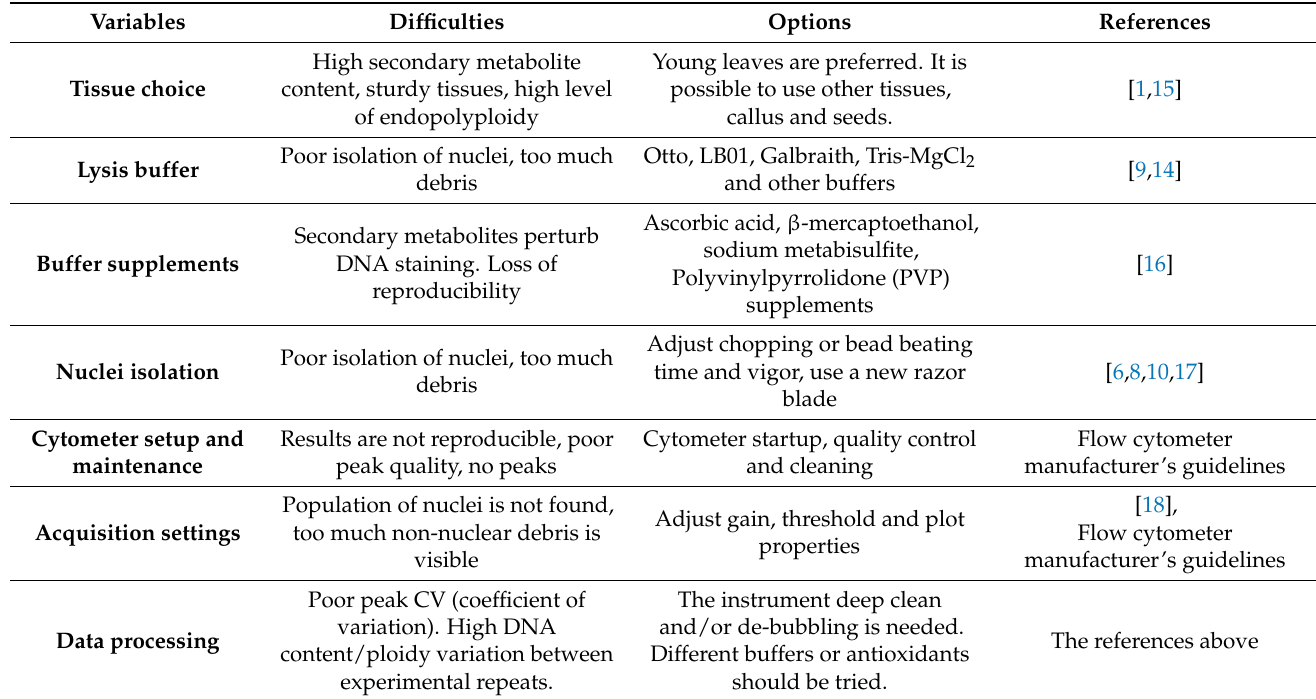
Table 1. Key factors for flow cytometry setup and